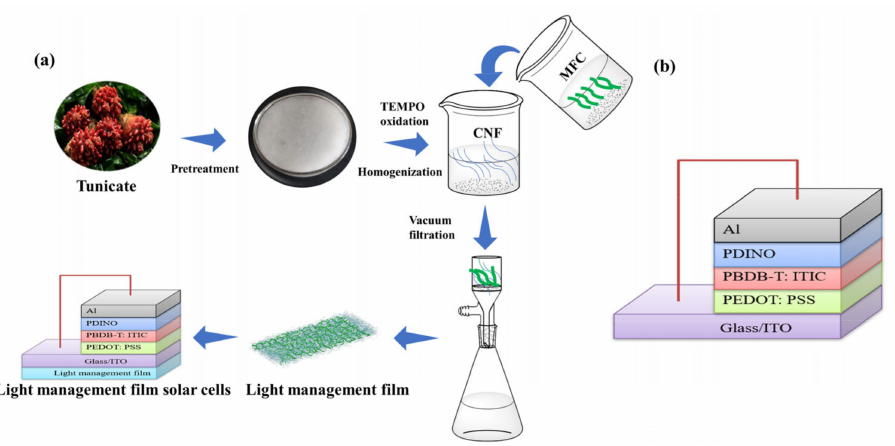
Figure 1. ( a ) Flow diagram for the preparation of tunicate cellulose film and the solar cell with cellulose film. ( b ) Schematic structure of a conventional organic solar